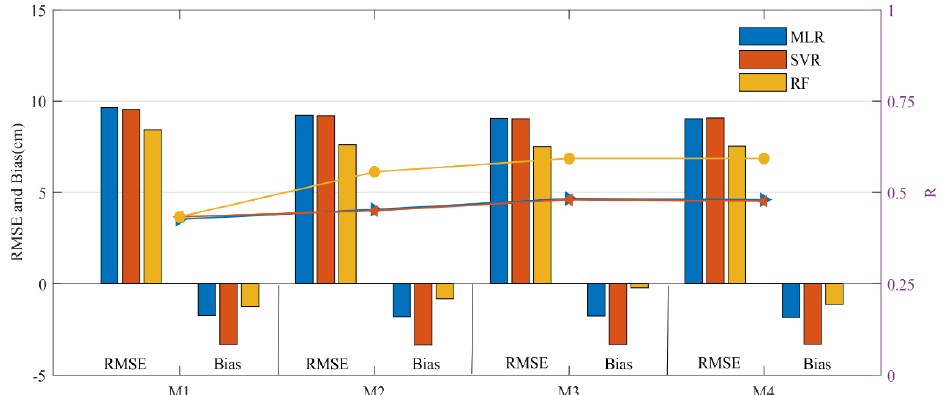
Figure 3. Comparison of the accuracy obtained with four different combinations across three regres- sion models.